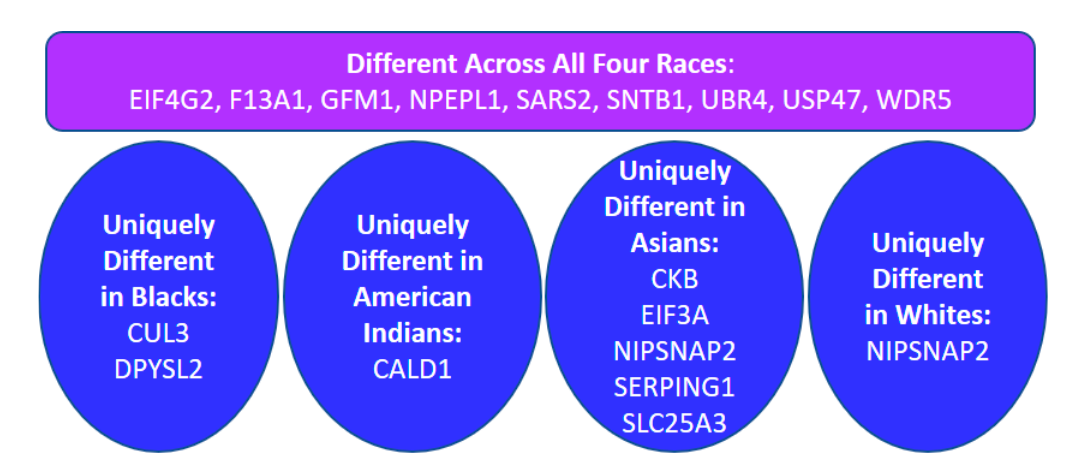
Figure 1. Heat map of log2 normalized levels for each protein found to be present at significantly different levels across the four races.